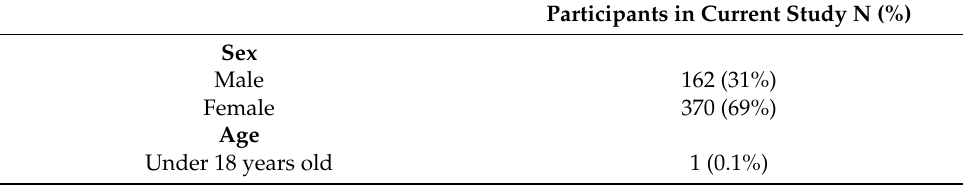
Table 2. Descriptive